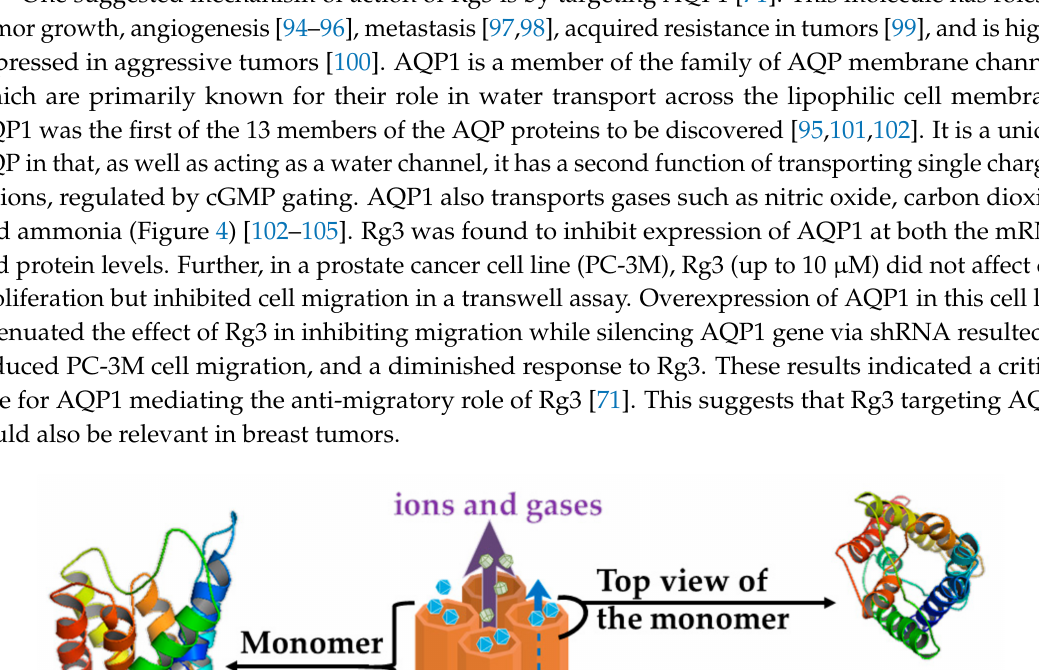
Table 2. Suggested mechanisms of inhibition of migration and invasion in different cancer models. The function of different epimers are indicated by symbols; * and 20(R)-Rg3, respectively.